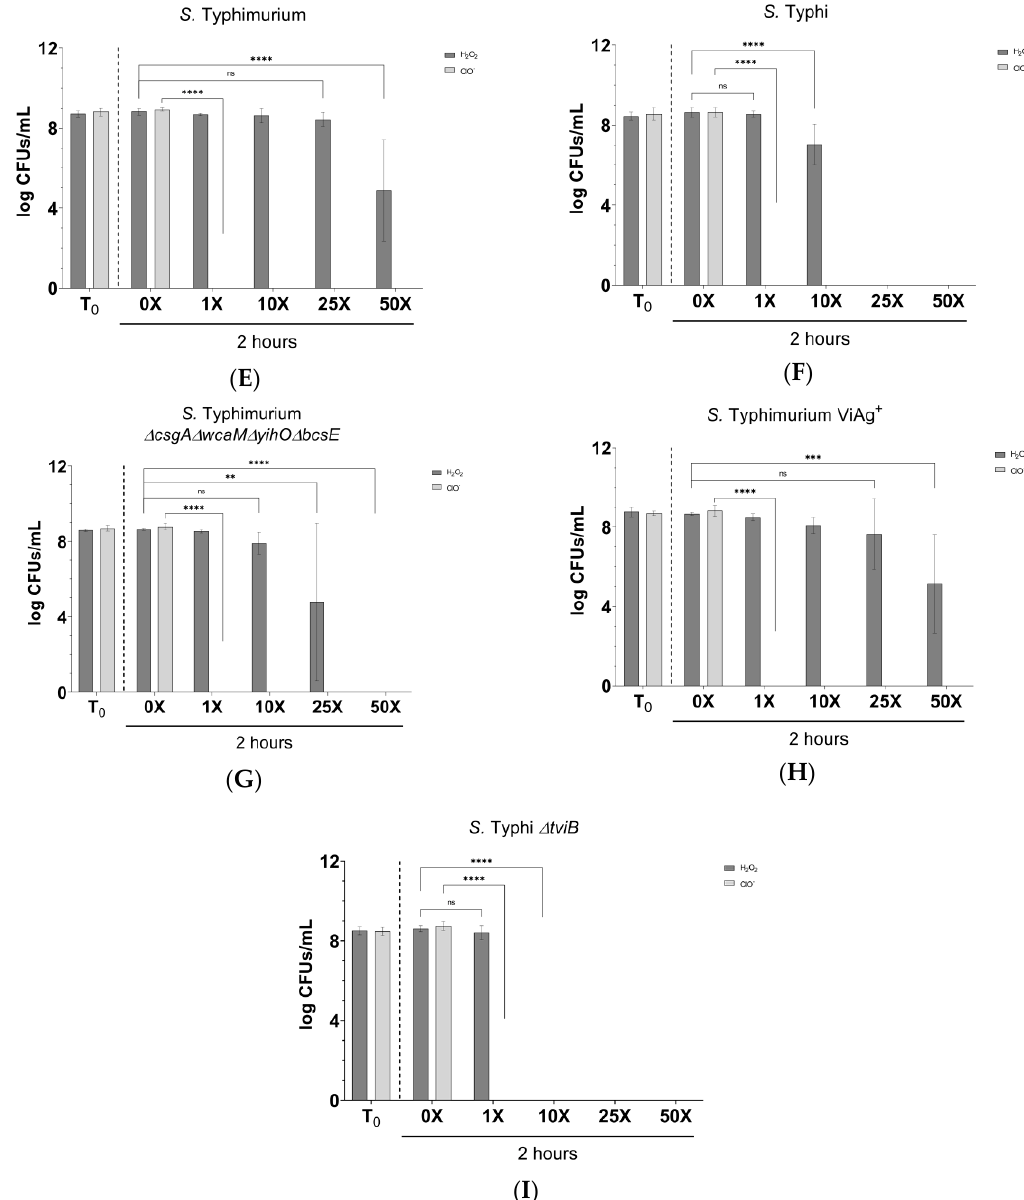
Figure 5. Sensitivity and tolerance to oxidative species. JSG4383 used for WT S. Typhi. ( A , B ) Growth of WT planktonic Salmonella in the presence of H 2 O 2 demonstrating a minimum inhibitory concentration (MIC) of 2.5 mM for both serovars. ( C , D ) Growth of WT planktonic Salmonella in the presence of ClO − demonstrating a MIC of 500 µg/ml for both serovars. ( E – I ) CFU enumeration of biofilm aggregates challenged with H 2 O 2 supplied at 1× (2.5 mM), 10× (25 mM), 25× (62.5 mM), or 50× (125 mM) the WT planktonic MIC or ClO − supplied at 1× (0.50 mg/mL), 10× (5 mg/mL), 25× (12.5 mg/mL), or 50× (25 mg/mL) the WT planktonic MIC. Significant reductions in tolerance were identified by comparing control (0×) CFUs with the CFUs of each concentration tested by two-way ANOVA with Tukey’s multiple correction method (**, P < 0.01; ***, P < 0.0005; ****, P < 0.0001). All experiments were conducted in triplicate and the data are the averages of three independent experiments. Error bars indicate SD.